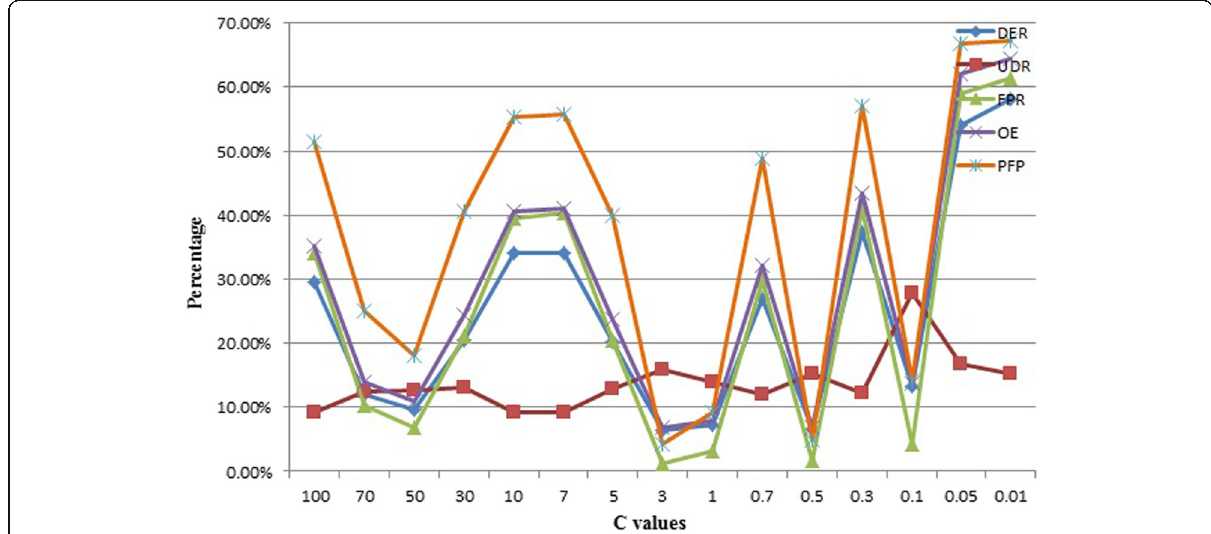
Fig. 6 The performance metrics of AdaBoostLSVM with optimal ε th value ( ε th =